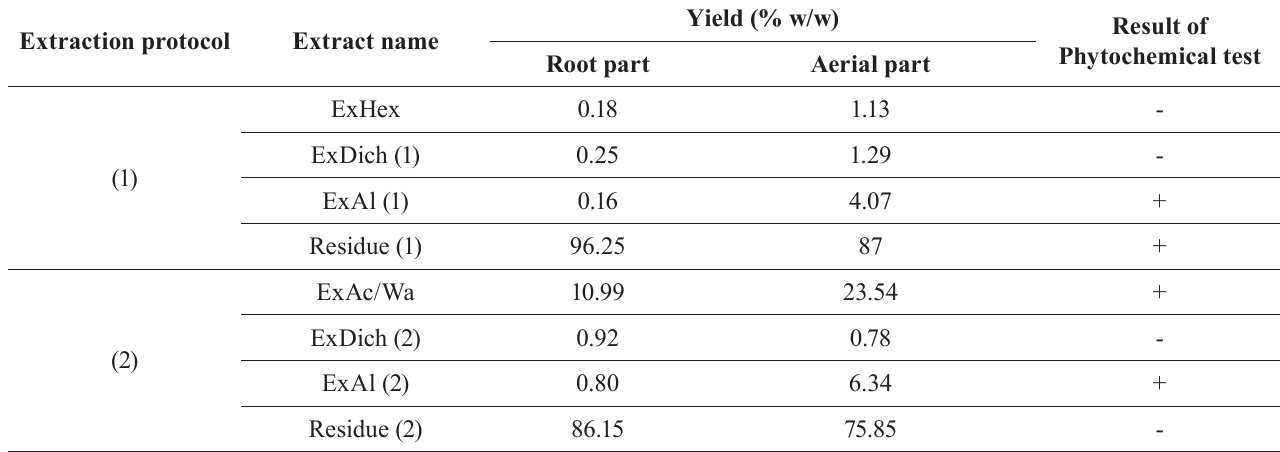
TABLE I - Q uantitative results and phytochemical test of Haloxylon scoparium extracts obtained by two extraction protocols of both plant parts